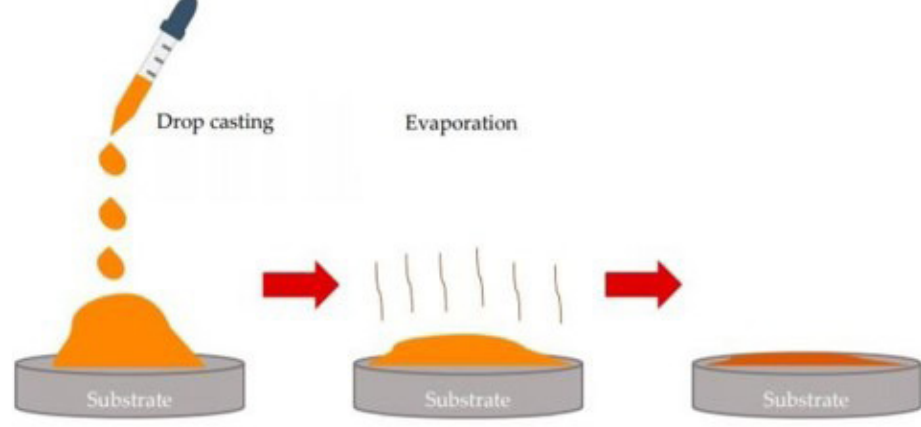
Figure 2. Scheme showing the Drop casting deposition process 11 .